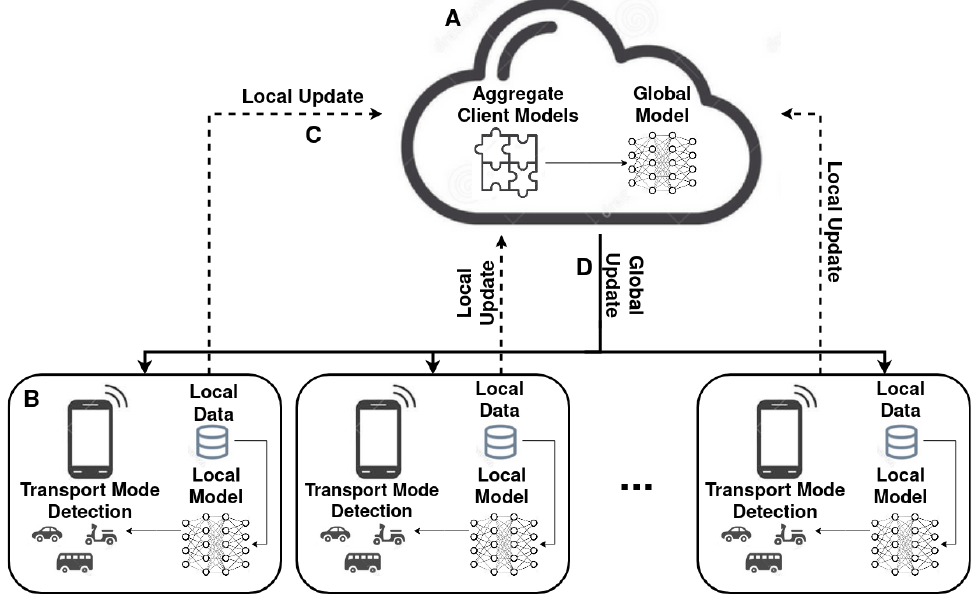
Figure 1. Overview of